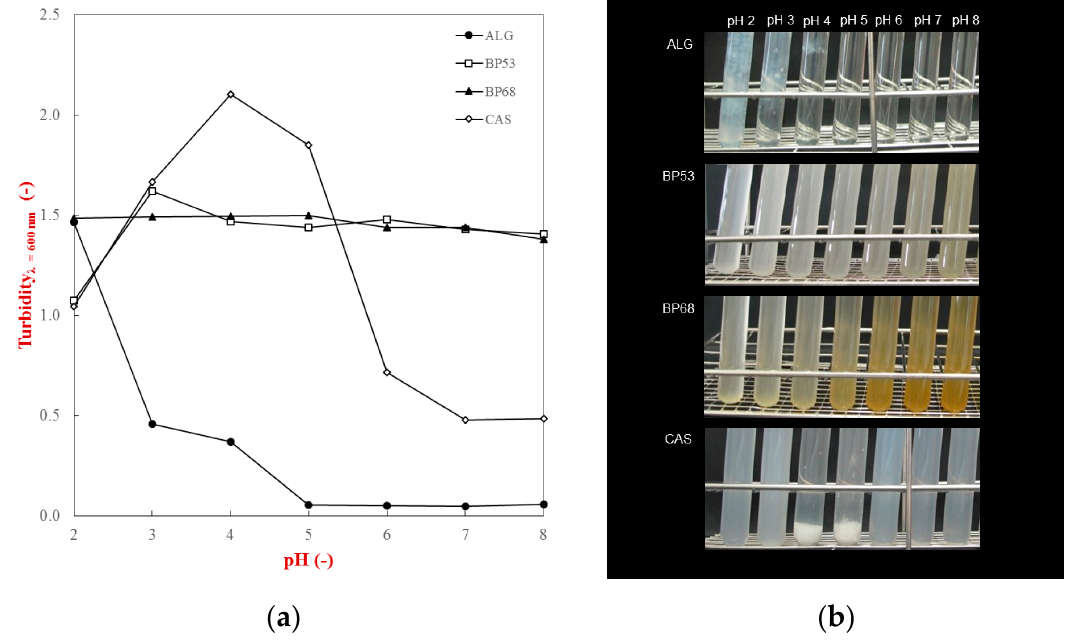
Figure 2. Turbidity ( a ) and phase separation ( b ) of single biopolymer solutions ( c biopolymer = 0.1%) as a function of pH (2–8): caseinate (CAS), alginate (ALG), sugar beet pectin DE 53% (BP53), and sugar beet pectin DE 68% (BP68).